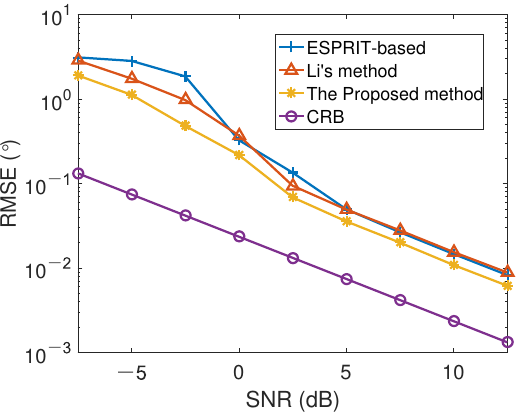
Figure 6. Gain-phase error estimation RMSE performance versus SNR, L =